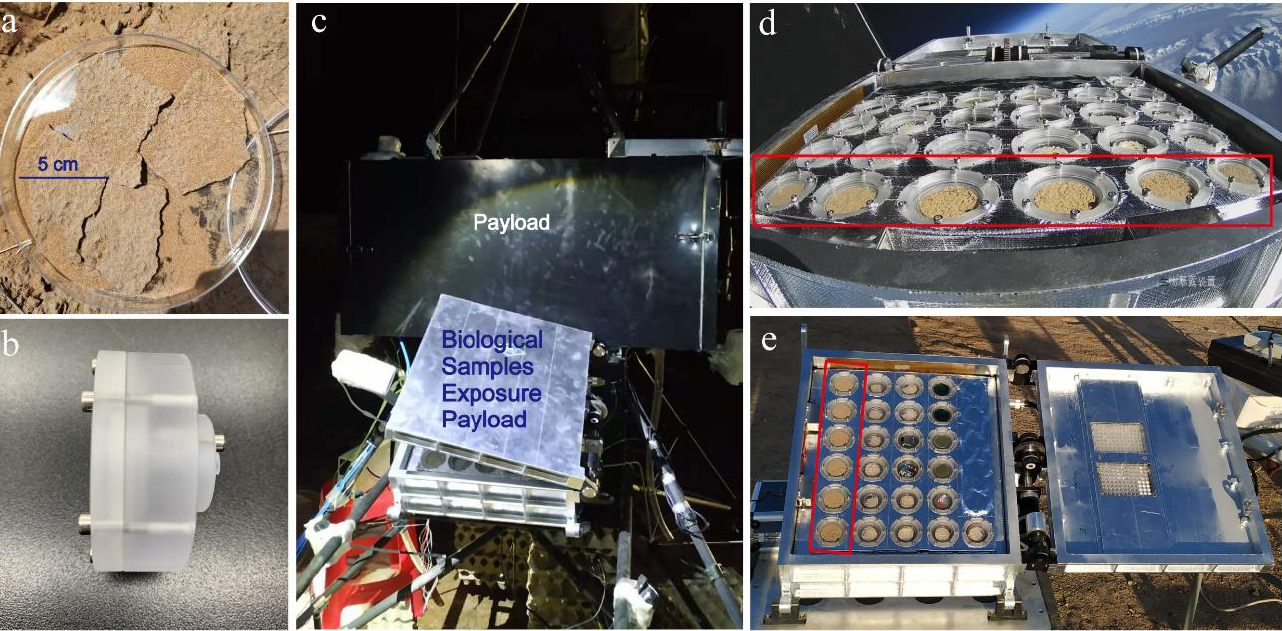
Figure 1. Sample preparation and experimental design. ( a ) Cyanobacterial crusts collected from Shapotou; ( b ) side structure of sample box; ( c ) biological samples exposure payload tilted on the payload; ( d ) cyanobacterial crusts in the stratosphere during light exposure; ( e ) cyanobacterial crusts on the ground. Cyanobacterial crusts are shown in the red wireframe.